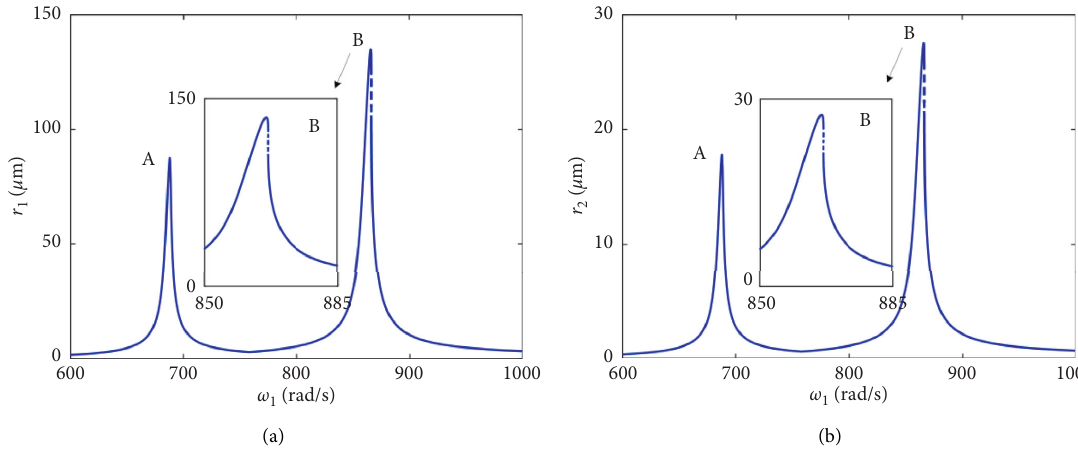
Figure 8: Amplitude frequency curves for the bifurcation mode of the hysteresis set curve H ( k n � 20 × 10 23 N/m 3 , k s � 10 × 10 8 N/m). (a) For the LP rotor. (b) For the HP rotor. Solid lines represent stable solutions, and dotted lines represent unstable